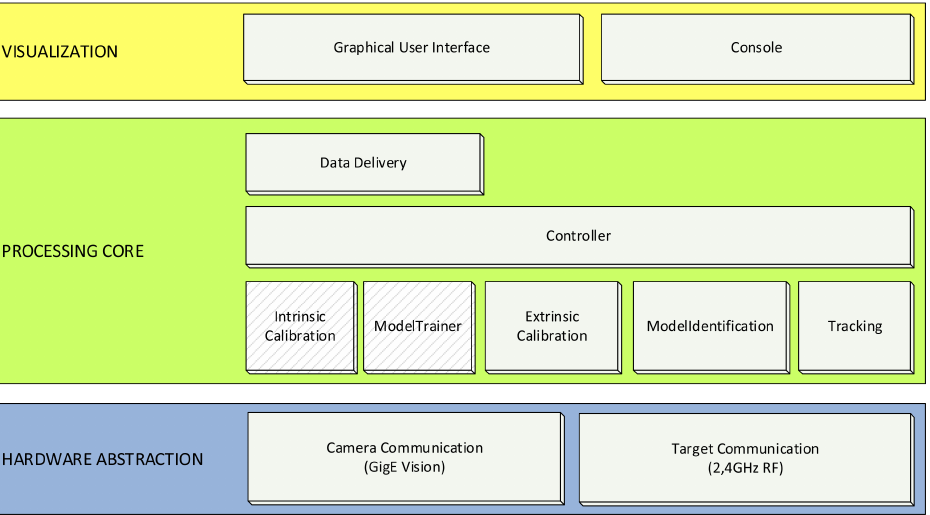
Figure 16. Software architecture and modules.